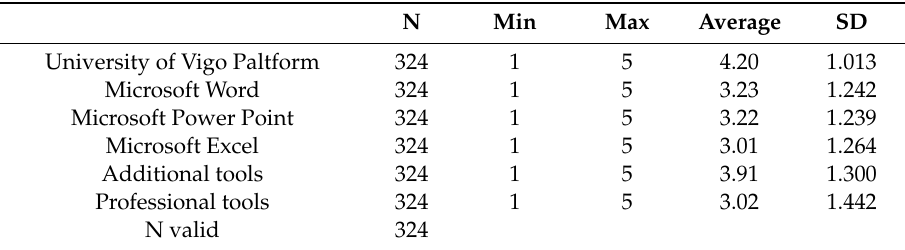
Table 2. Use of digital tools.